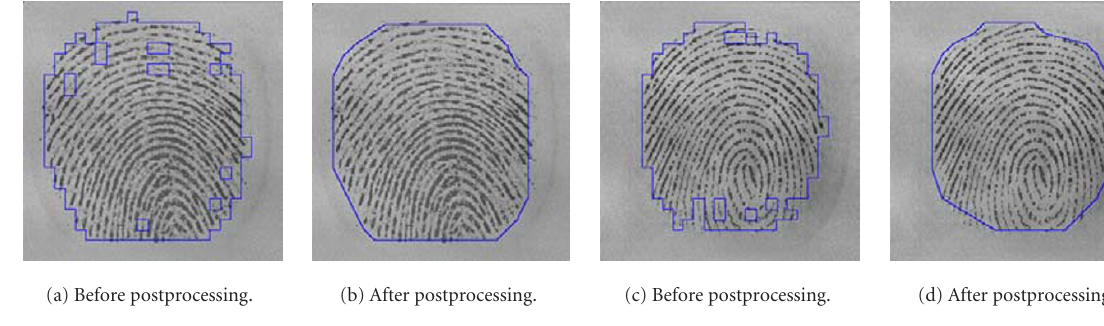
Figure 19: Two examples of the postprocessing.